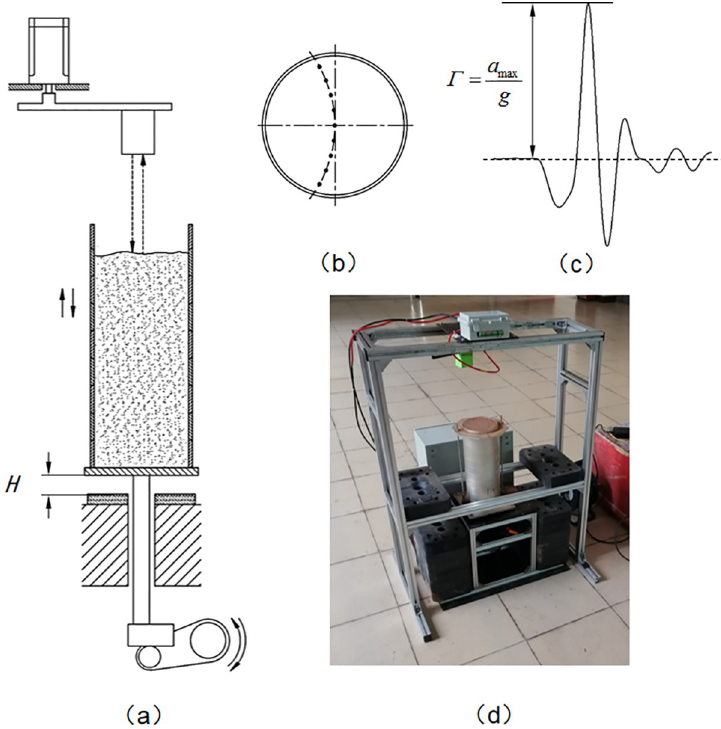
Fig 2. The experimental setup. (a) A schematic diagram of our experimental setup with the container installed on the drop tester, where dashed arrows indicate measuring the drop distance of soil surface using a laser ranging sensor, and the drop height, H , is the distance the container could be lifted. (b) The top view of ranging points marked with solid circles on soil surface. These points are evenly distributed along the arc passing through the container axis. (c) The typical acceleration waveform of a drop shock, where the intensity, Γ , is defined as the ratio of the peak acceleration, a max , to the gravitational acceleration, g . (d) A picture of the apparatus prepared to